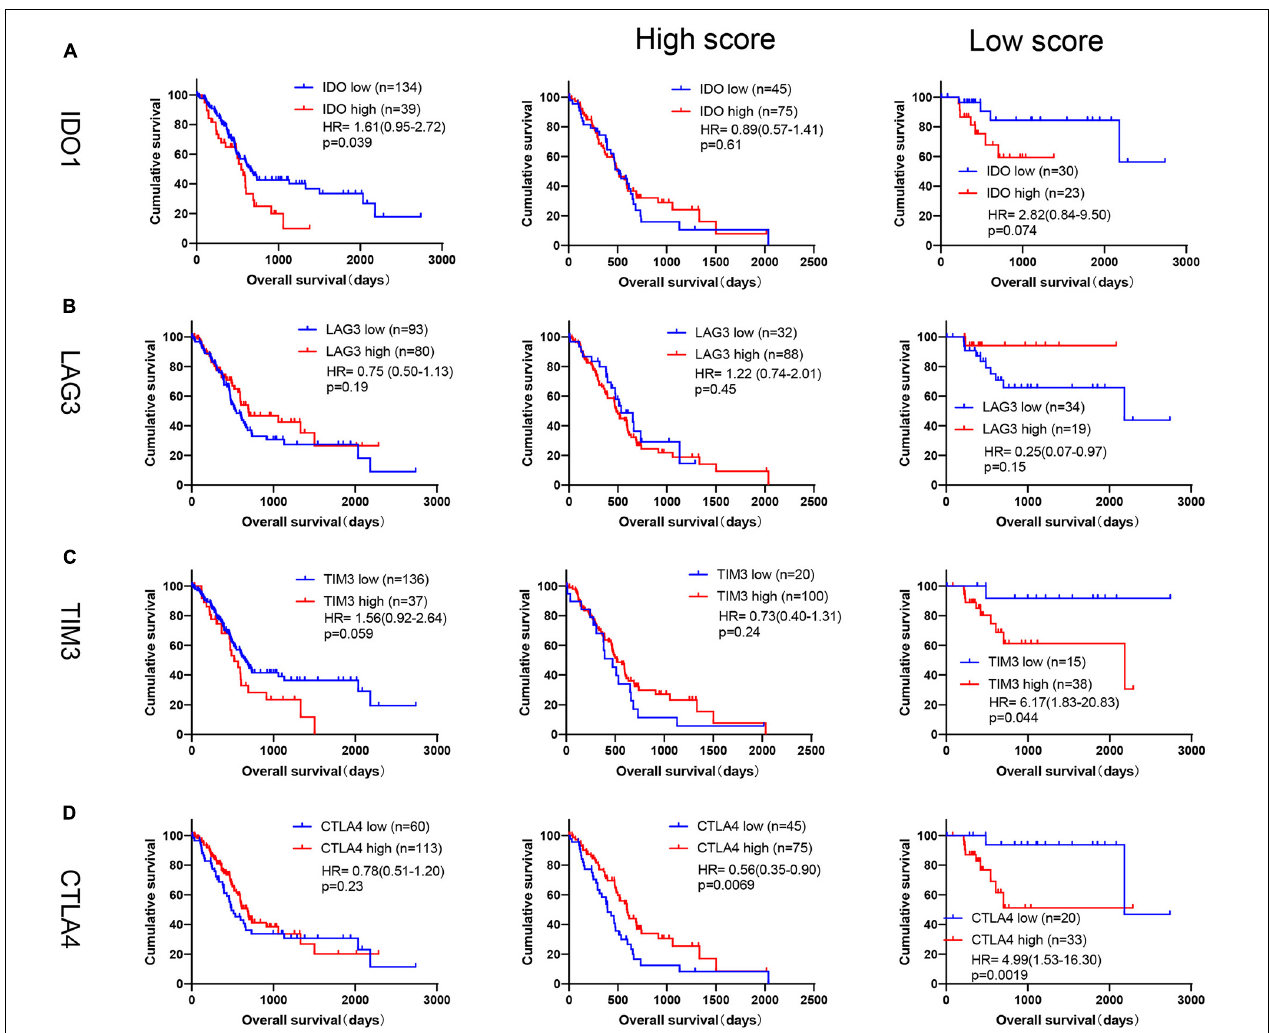
FIGURE 9 | Prognosis analysis of TIM3, CTLA4, IDO1 and LAG3 in TCGA database. Kaplan-Meier survival curves of (A) IDO1 (High score: PD-L1 high, n = 75; PD-L1 low, n = 45. Low score: PD-L1 high, n = 23; PD-L1 low, n = 30), (B) LAG3 (High score: PD-L1 high, n = 88; PD-L1 low, n = 32. Low score: PD-L1 high, n = 19; PD-L1 low, n = 34), (C) TIM3 (High score: PD-L1 high, n = 100; PD-L1 low, n = 20. Low score: PD-L1 high, n = 38; PD-L1 low, n = 15), (D) CTLA4 (High score: PD-L1 high, n = 75; PD-L1 low, n = 45. Low score: PD-L1 high, n = 33; PD-L1 low, n = 20) expression in all patients, or by subgroup analysis based on our immune signature in TCGA